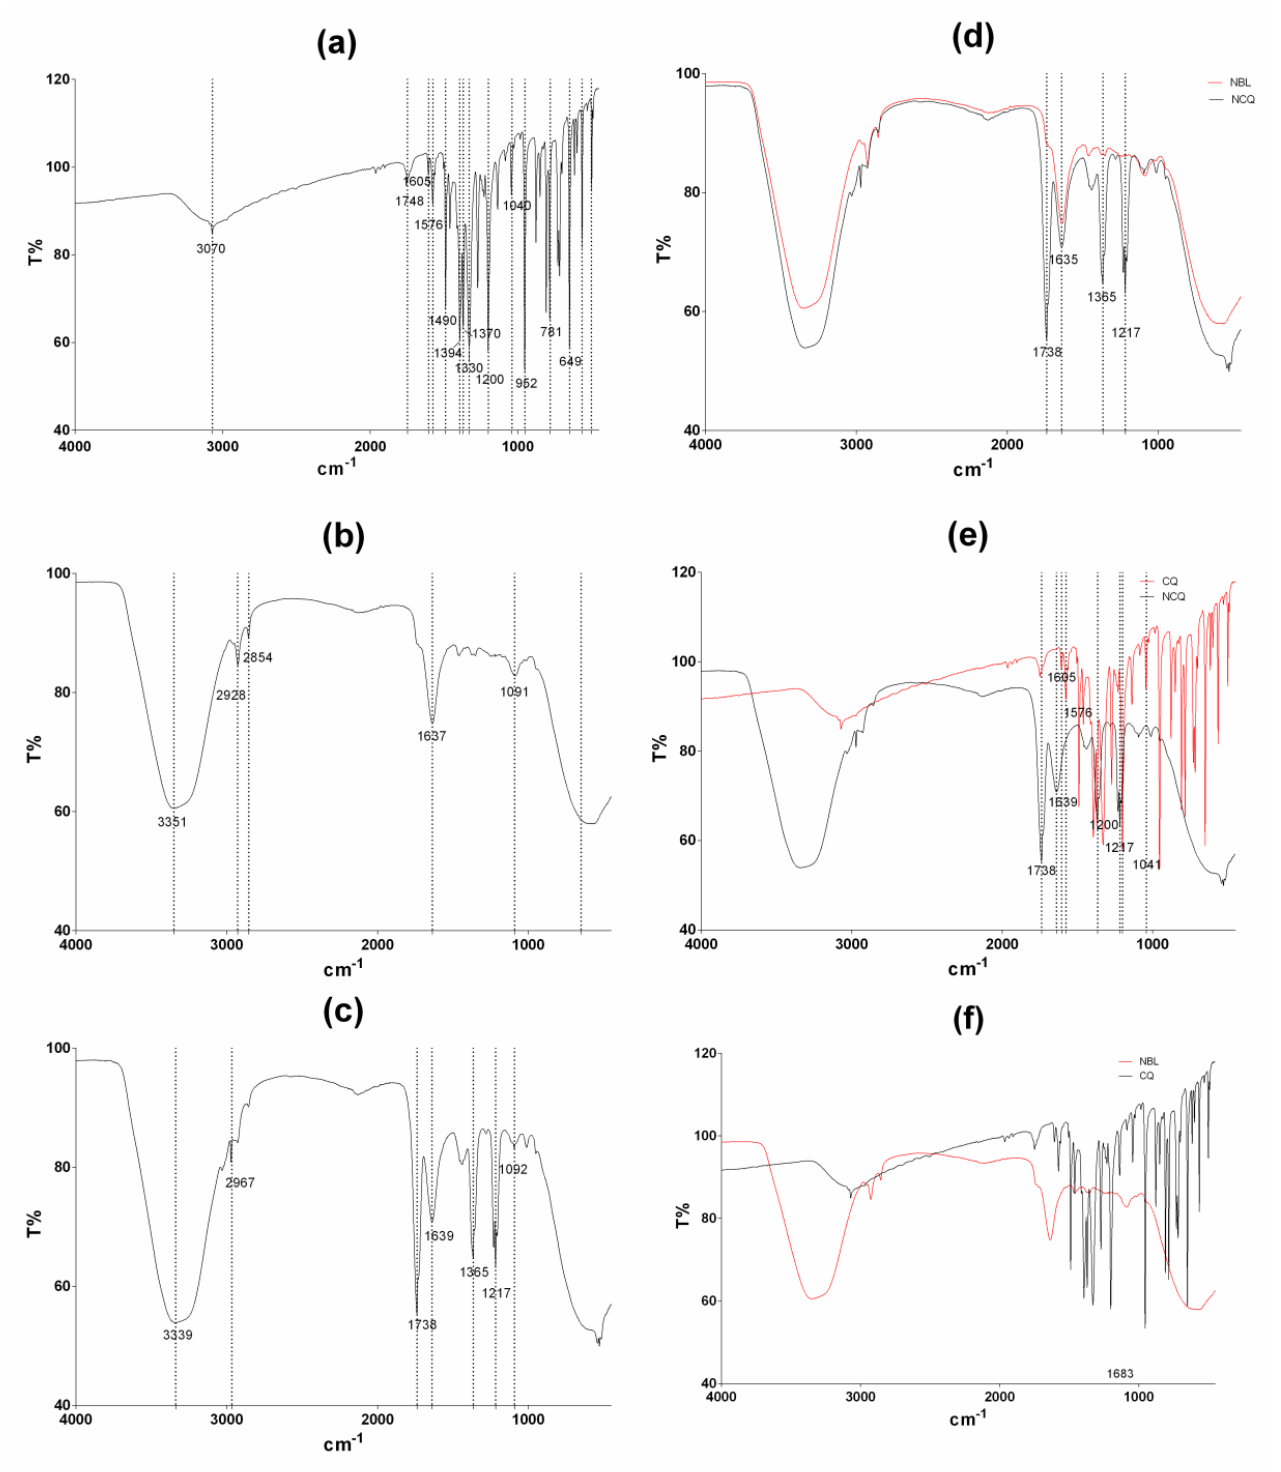
Figure 3. FT-IR of bulk CQ ( a ), a placebo nanocarrier ( b ), CQ-loaded nanocarrier (LBN-CQ) ( c ), the spectra of placebo and LBN-CQ ( d ), the spectra of bulk CQ and LBN-CQ ( e ) and the spectra of bulk CQ and LBN-BL ( f ).